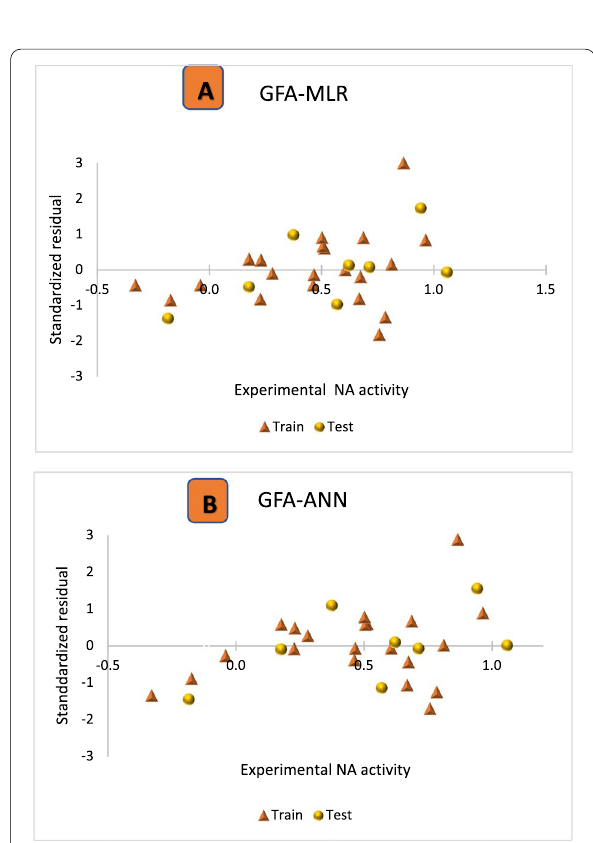
Fig. 4 Plot of standardized residuals versus experimental NA activity, A GFA-MLR model, B GFA-ANN model